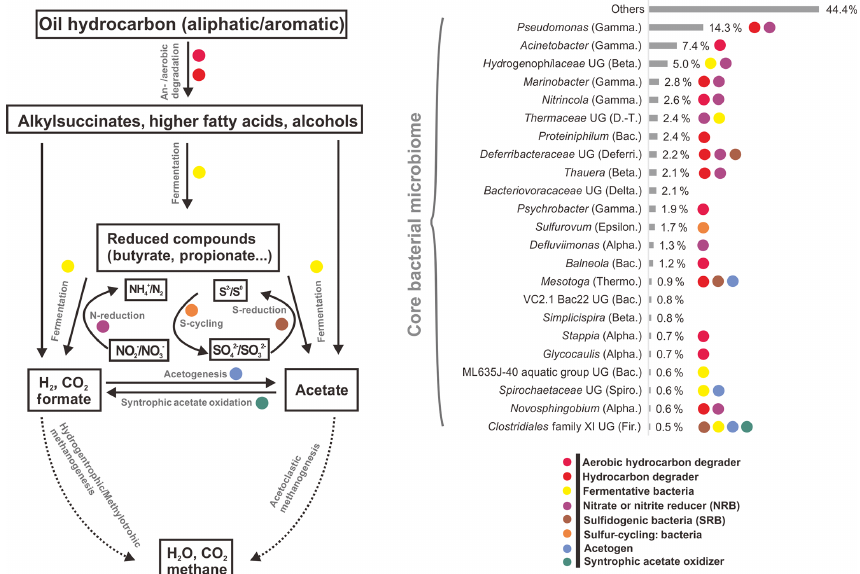
Figure 2. Average abundances and functional roles of core bacterial microbiome in all petroleum samples (including aqueous- and oil- phase samples). Core microbial OTUs (23 OTUs) were affiliated to the most abundant genera. The functional roles were assigned according to reference publications (Supplement). Degradation pathway was modified from Mbadinga et al. (2011). Abbreviations: Alpha., Beta., Gamma., Delta., Epsilon. (Alpha-, Beta-, Gamma-, Delta-, Epsilonproteobacteria), D.-T. (Deinococcus–Thermus), Bac. (Bacteroidetes), Deferri. (Deferribacteres), Thermo. (Thermotogae), Spiro. (Spirochaetes), and Fir. (Firmicutes). UG stands for uncultured genus.